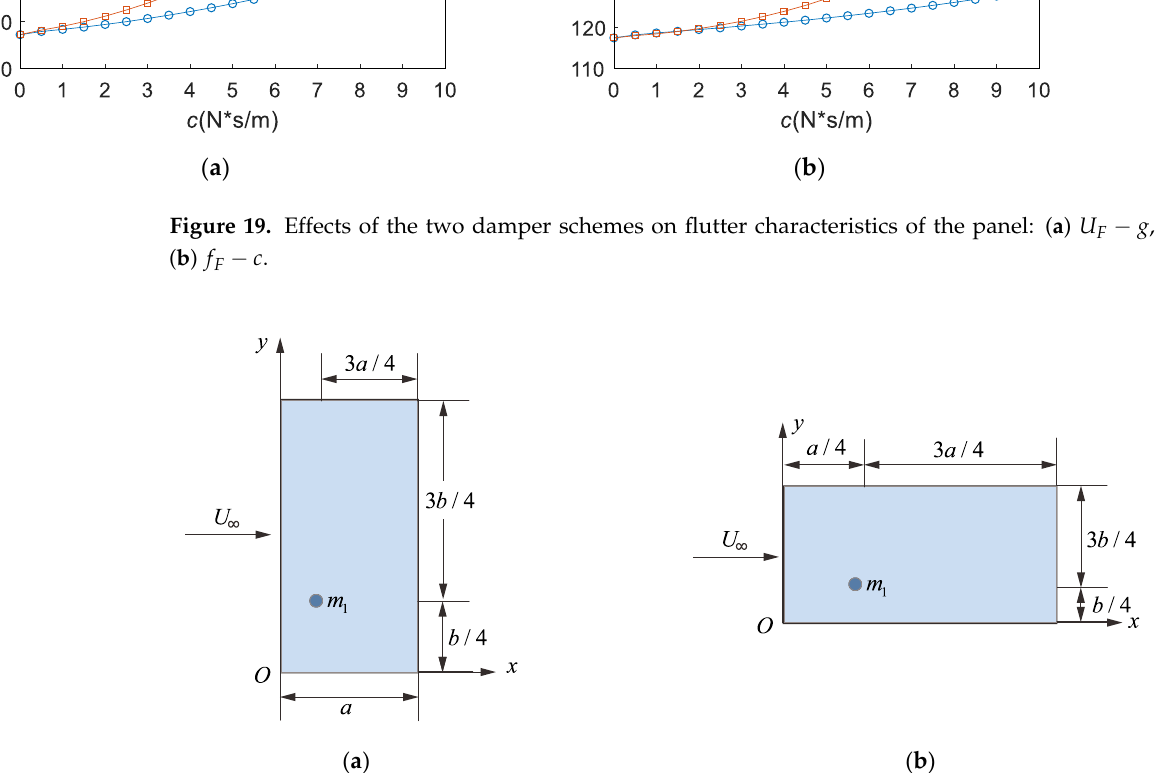
Figure 19. Effects of the two damper schemes on flutter characteristics of the panel: ( a ) f c  . F